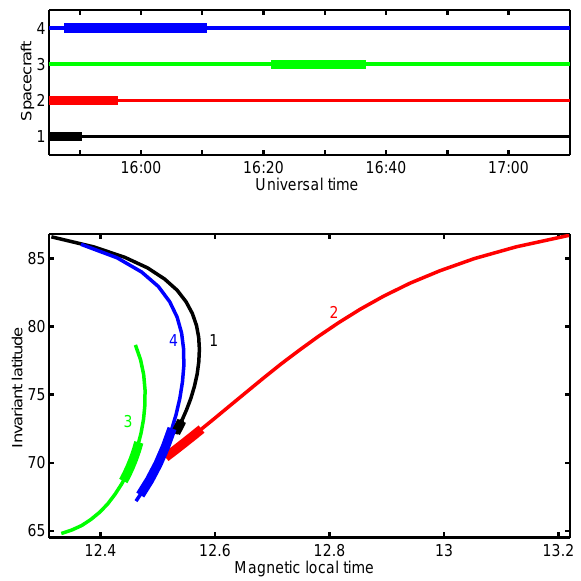
Fig. 12. The four Cluster satellites observing the same region with LHCs at different times. The narrow lines means that we have high resolution (BM1) data, and the thick lines that there are identified LHCs. Note that spacecraft 1 and 2 have LHCs already at the be- ginning of the time